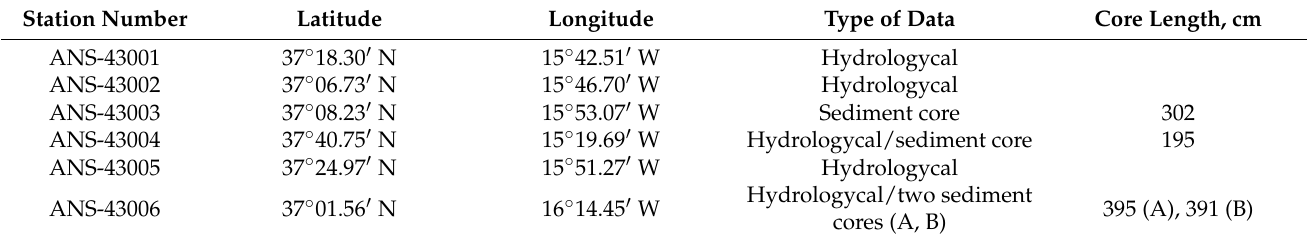
Figure 3. Substrate types classification established according to echo-types [14] in the Discovery Gap. Table 2. Hydrological measurement and sediment core locations and type of